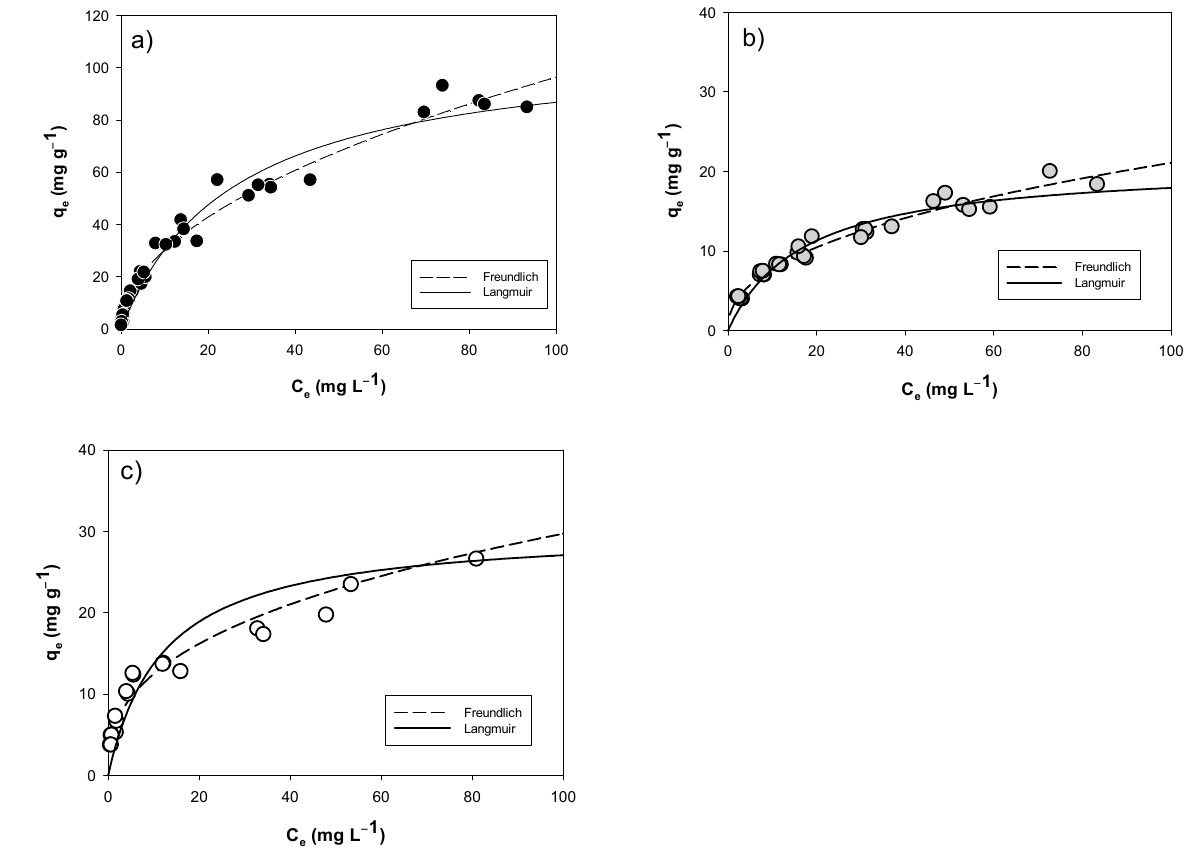
Figure 5. Isotherm curves of TCE onto investigated BCs: ( a ) PWBC, ( b ) RHBC and ( c ) EuFeBC. Table 3. Optimized parameters of Freundlich and Langmuir models.